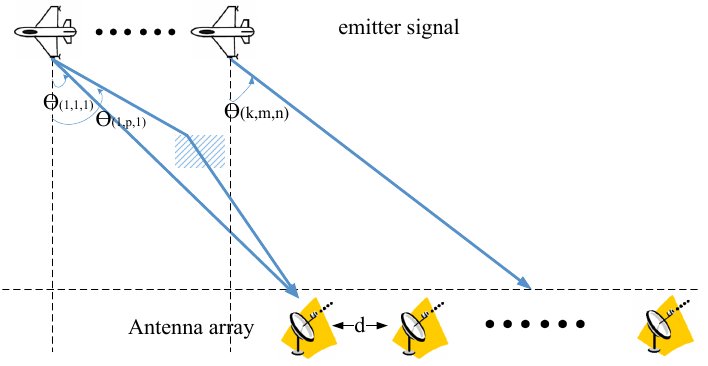
Figure 4. System model for DOA estimation. Background scatter is denoted by